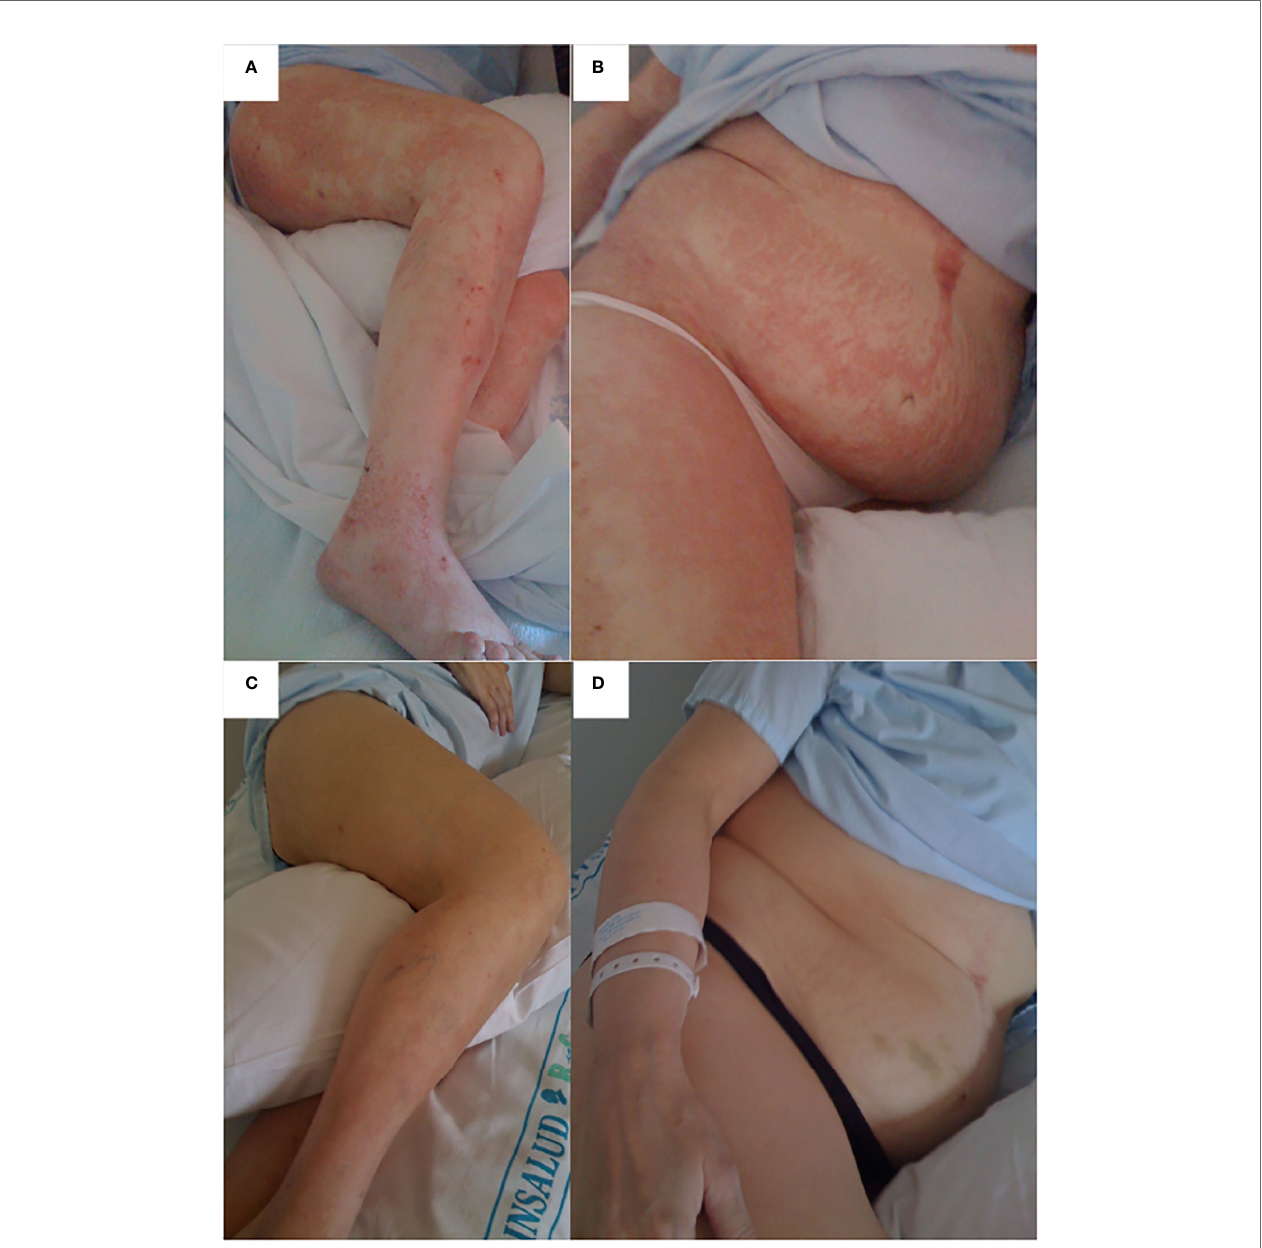
FIGURE 1 | Erythematous desquamating dermatitis due to zinc de fi ciency. Lesions affect perioral, external genitalia and acral areas, with progressive dissemination to the rest of the body. Erythematous desquamating dermatitis affecting legs (A) , upper right leg, abdomen, chest and right arm (B) . Erythematous dermatitis in legs after three days of intravenous zinc supplementation and oral supplements administration (C) ; improvement was also observed in the upper right leg, abdomen, chest and right arm (D)